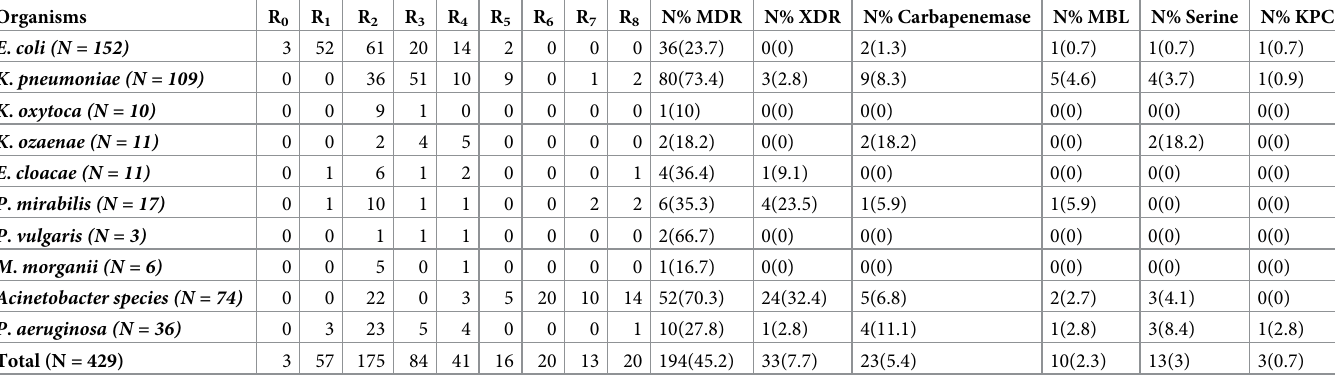
The prevalence of multi-drug resistant and extremely drug resistant, and carbapene- mase-producing GNB. Of 194 MDR GNB isolates, 45% were isolated from patients admitted to the intensive care unit, 83.4% were isolated from patients previously exposed to different antimicrobial agents, 28% were isolated from patients under mechanical ventilation and/or urinary catheterization, and 34.7% were isolated from patients with hospital-acquired (HAI) pneumonia (Table 3).